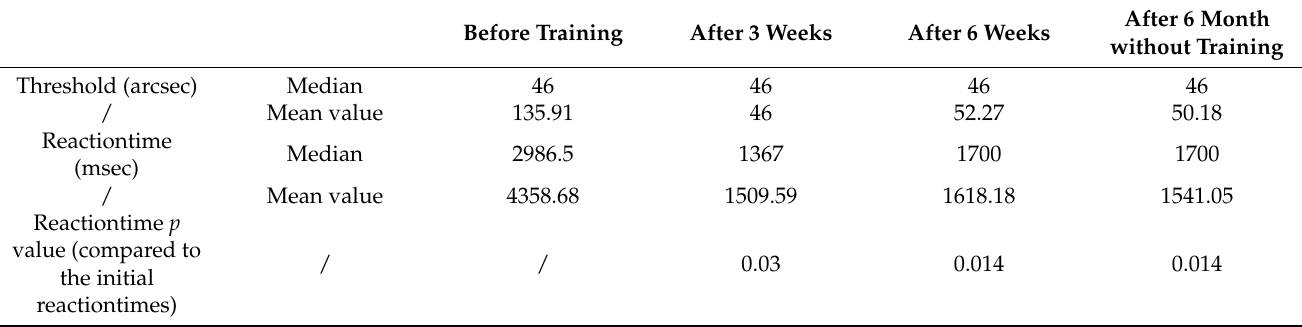
Table 4. Representation of the development of the median and mean value of the entire sample group’s stereoacuity, reaction time, and level of significance in the dynamic